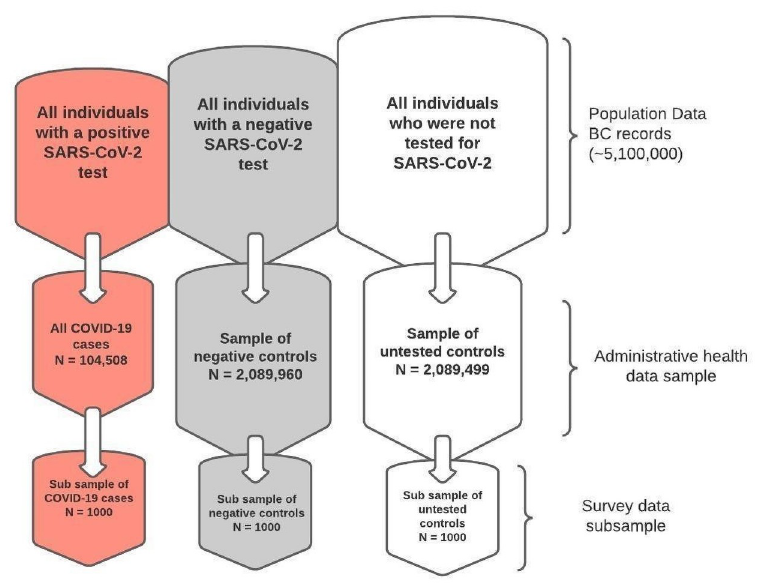
Fig 2. Recruitment flowchart (Records from February 2020–April